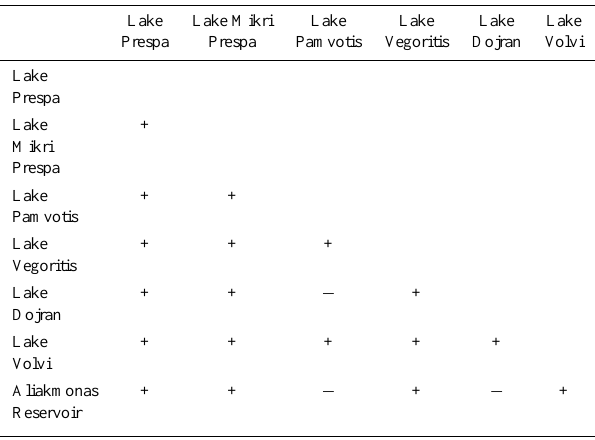
Table 3. Results of exact test for significant pairwise genetic dif- ferences (level 0.05) in Dreissena presbensis from different water bodies.